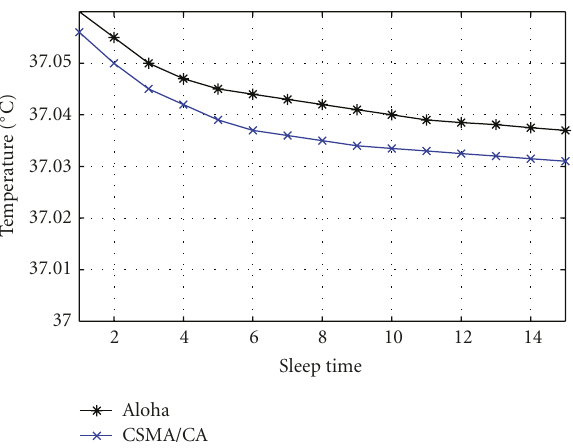
Figure 7: CCA in on-body and in-body sensor networks.